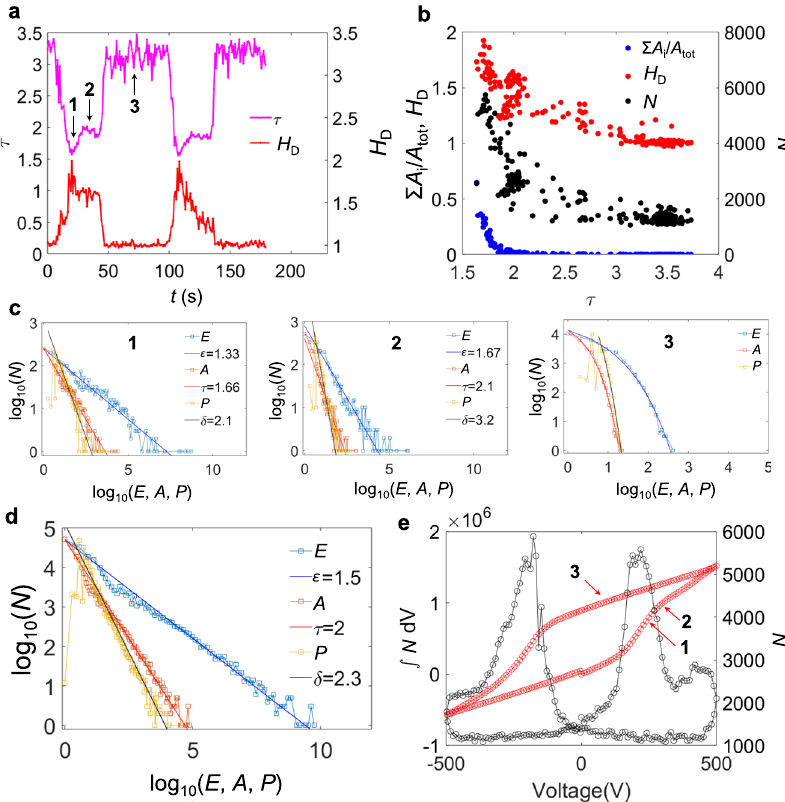
Fig. 3 Scale-invariant avalanches in PMN-PT. a H D and τ as a function of time. b H D , Σ ( A i )/ A tot (proportion of switched regions with respect to the total area) and N (avalanche activity, de fi ned as the number of switched regions between t and t + δ t ) as a function of τ . c E (energy), A (area) and P (perimeter) distribution at the time steps marked as 1, 2 and 3 by arrows in a . d E , A and P distribution from all the time steps. e N as a function of the applied voltage (right axis) and its integration over the voltage applied (left